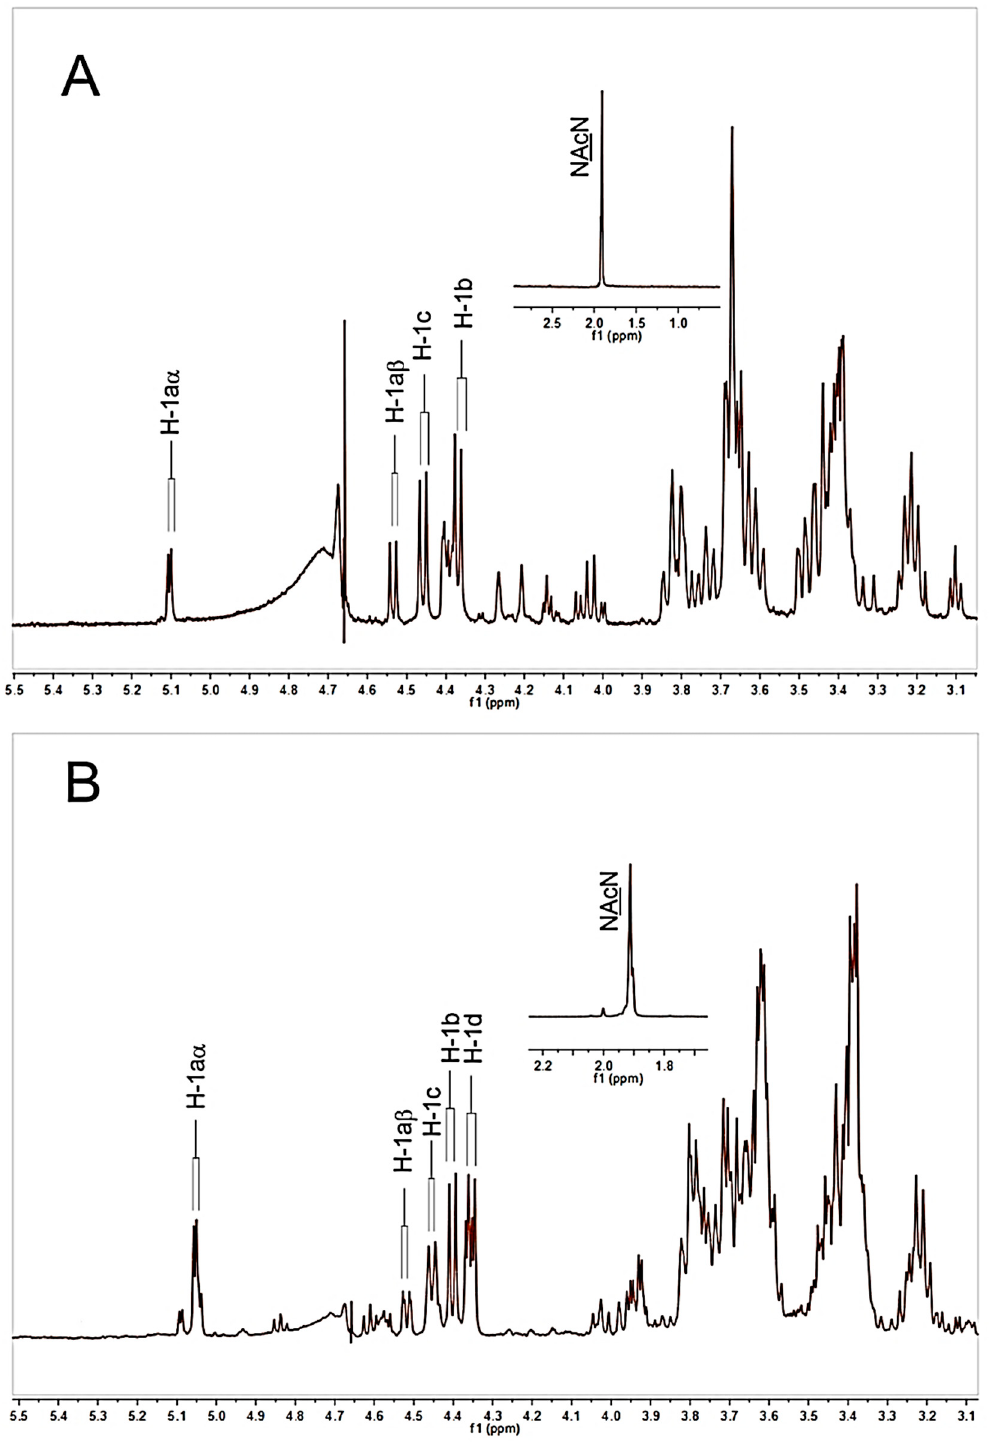
Figure 3. 1 H NMR spectra of HAOs. ( A ) DP3, ( B ) DP4. All samples were previously dissolved in deuterium oxide (D 2 O, 99.96%) and lyophilized three times to replace exchangeable protons.